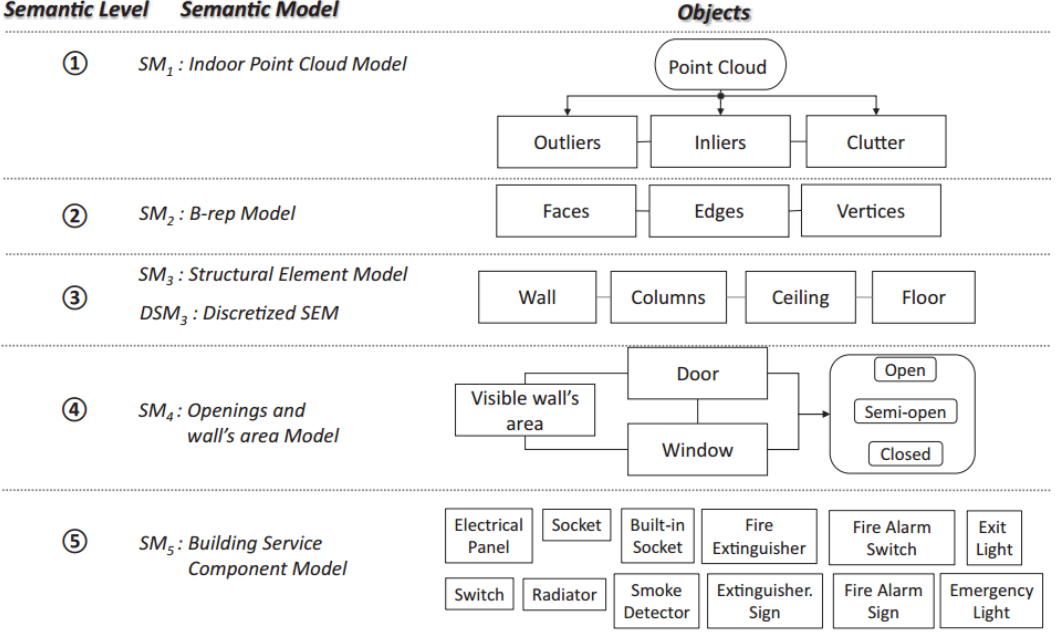
Figure 6. Levels of semantic 3D modeling [58].